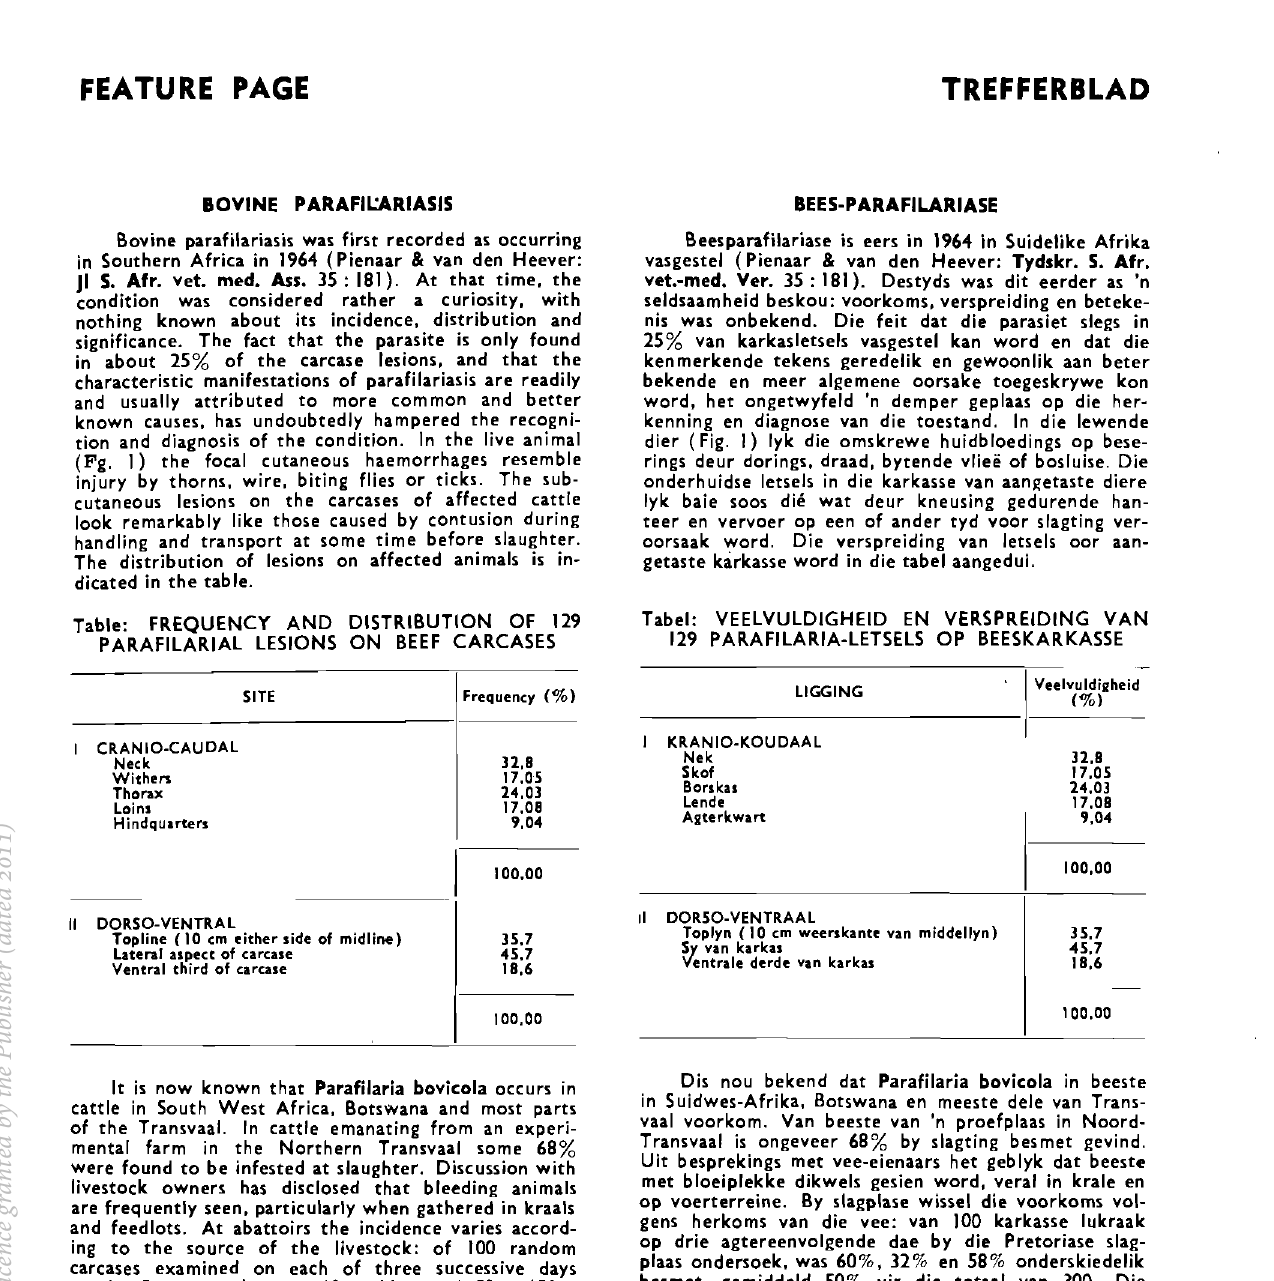
Table: FREQUENCY AND DISTRIBUTION OF 129 PARAFILARIAL LESIONS ON BEEF CARCASES